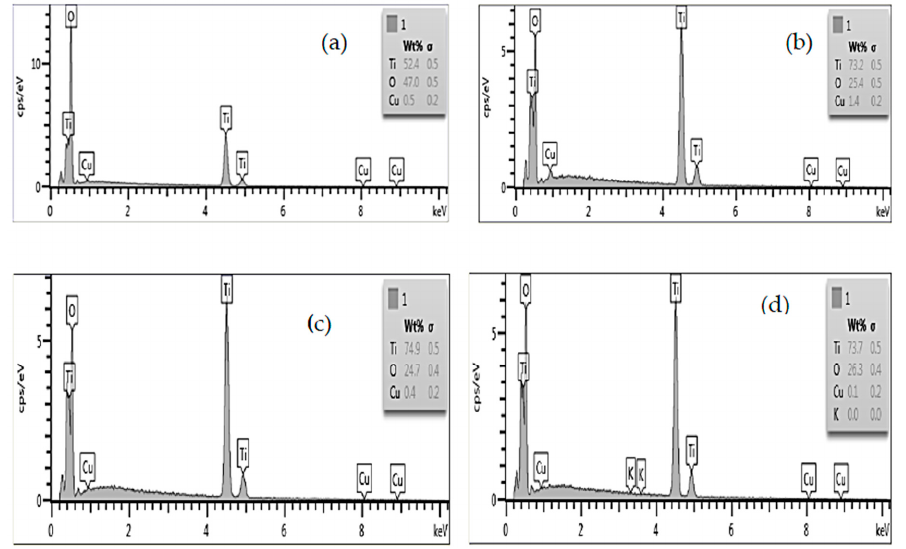
Figure 3. Energy dispersive X ‐ ray spectroscopy (EDX) spectra of ( a ) Cu ‐ 01; ( b ) Cu ‐ 02; ( c ) Cu ‐ 03; ( d ) Cu ‐ 04.